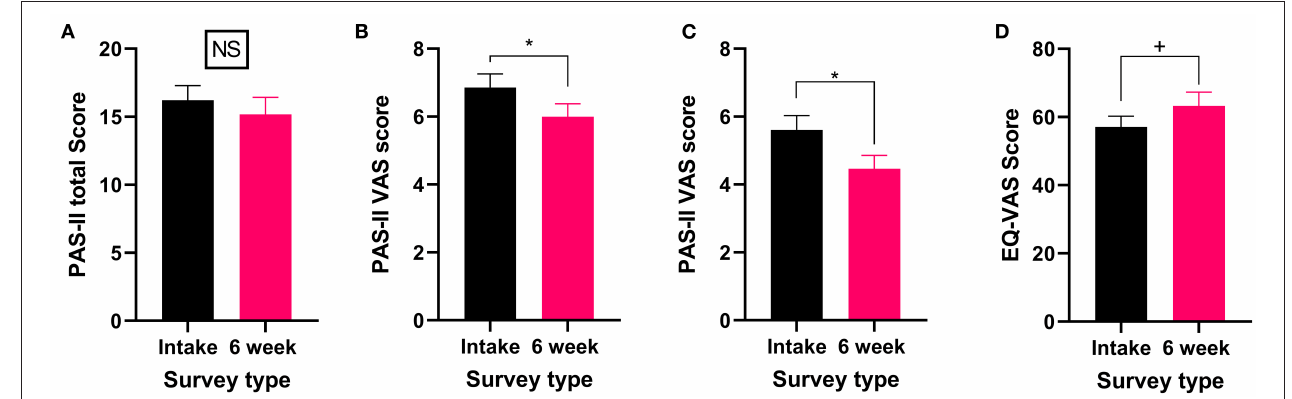
FIGURE 5 | Validated survey scores from the intake survey (baseline) and 6-week follow-up survey for patients reporting arthritis or another rheumatic disorder as their primary medical condition. Overall while total PAS-II score did not improve, both the pain VAS and global activity VAS scores showed improvements after 6 weeks of medical cannabis treatment. (A) Total PAS-II score (Wilcoxon test P > 0.05) did not significantly change after 6 weeks of medical cannabis treatment. (B) The pain VAS score contained within the PAS-II (Wilcoxon test P < 0.05) significantly improved from the intake survey to 6-week follow-up survey. (C) The global activity VAS score contained within the PAS-II (Wilcoxon test P < 0.05) significantly improved after 6 weeks of medical cannabis treatment. (D) EQ-VAS score was not significantly altered from the intake survey to the 6-week follow-up survey (Wilcoxon test P = 0.09), though there was a small trend toward improvement. (* P < 0.05, + P = 0.09, NS P > 0.05).